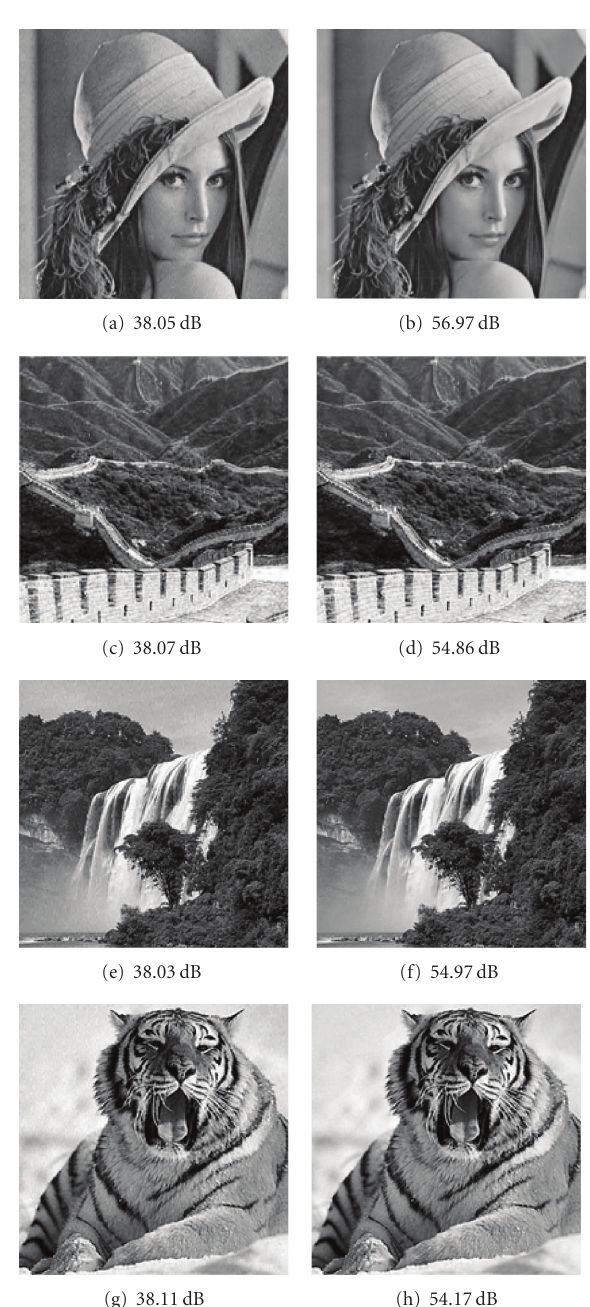
Figure 7: The watermarked images generated by the seller (left column) and buyer (right column),